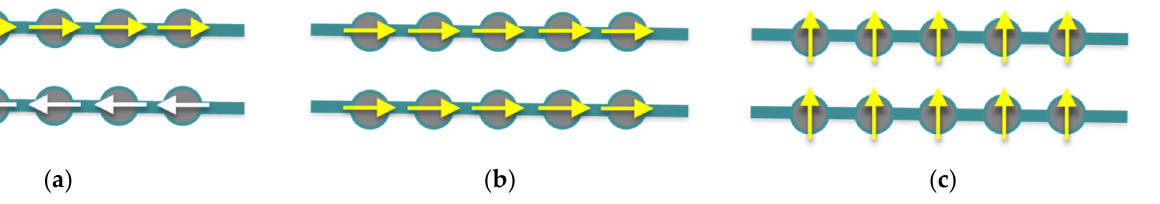
Figure 2. ( a ) A-type AFM bilayer with intralayer FM order and interlayer AFM order; ( b ) A-type AFM bilayer in an external in-plane magnetic field; ( c ) A-type AFM bilayer in an external out-of-plane magnetic field. Different external field can change the interlayer coupling into in-plane FM in 2 ( b ) or out-of-plane FM in 2 ( c ).